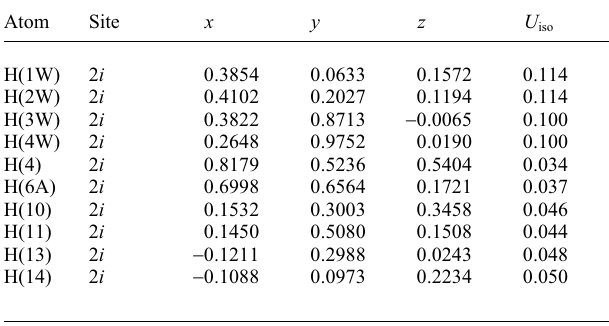
Table 3. Atomic coordinates and displacement parameters (in Å 2 )